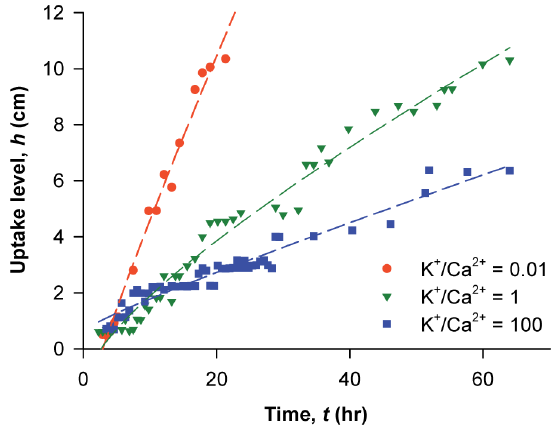
Figure 4. Effect of K + /Ca 2 + ratios on the uptake level of ionic solution. Temporal variations in the increase in ionic solutions with three K + /Ca 2 + ratios in the excised laurel stems and curve-fitted with 2-D diffusion-convection model. Variations in the increased K + /Ca 2 + ratios were quantified using a neutron imaging technique for 64 h. Orange circles denote K + /Ca 2 + =0.01; green rotated triangles denote K + /Ca 2 + =1; purple rectangles denote K + /Ca 2 + =100.